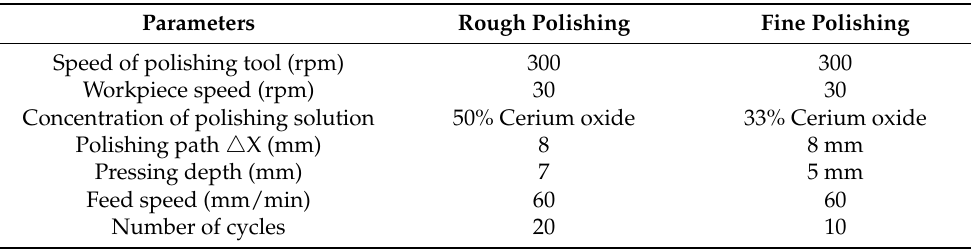
Table 3. Polishing